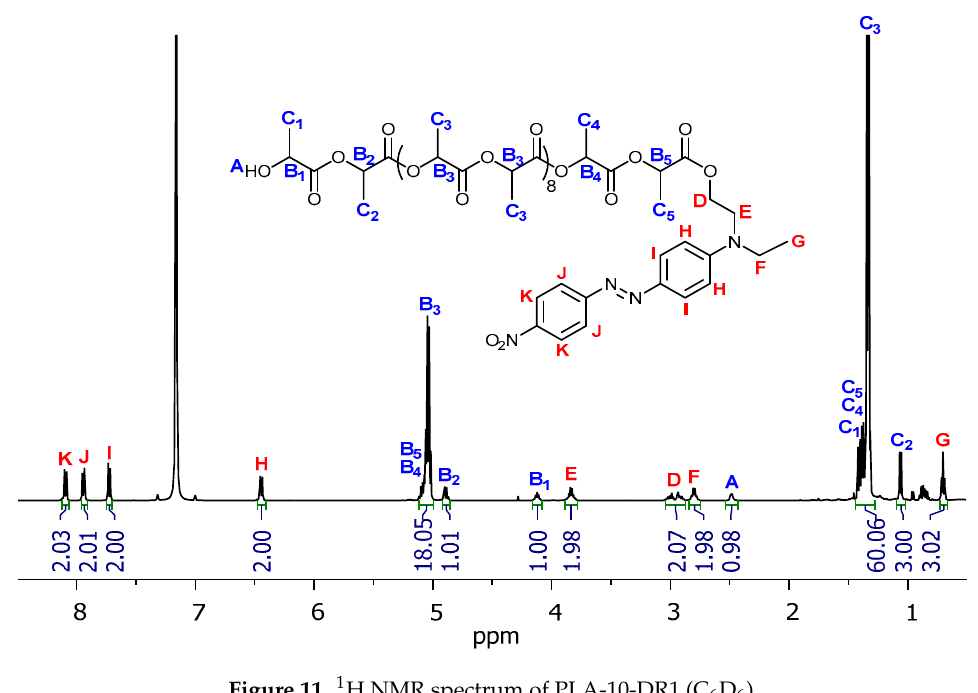
Figure 11. 1 H NMR spectrum of PLA-10-DR1 (C 6 D 6 ).